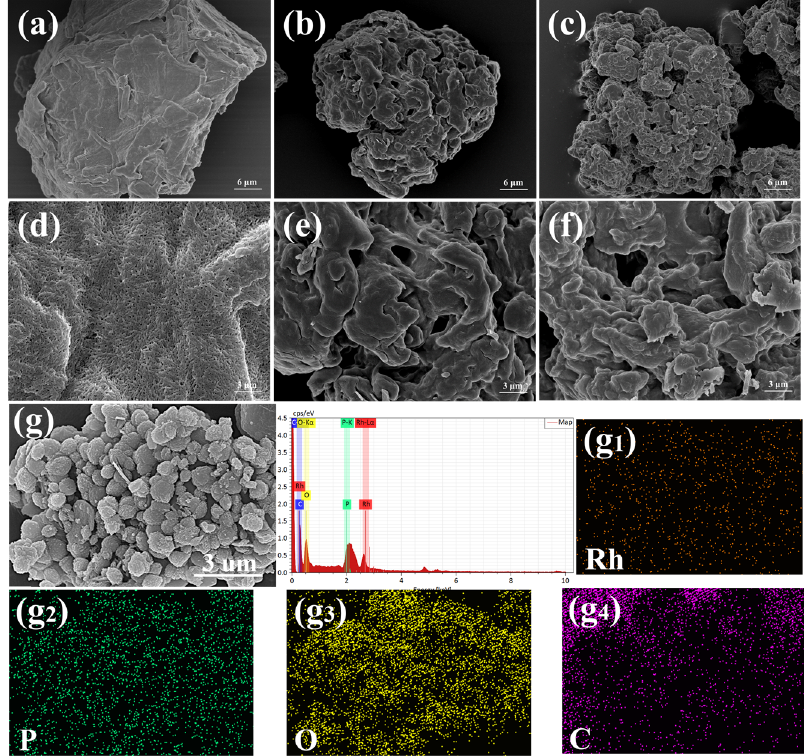
Figure 5. SEM images of MCC ( a , d ) DAC ( b , e ) DAC-BINAP ( c , f ) Rh/DAC-BINAP ( g ) and EDS images of different elements ( g 1 – g 4 ).